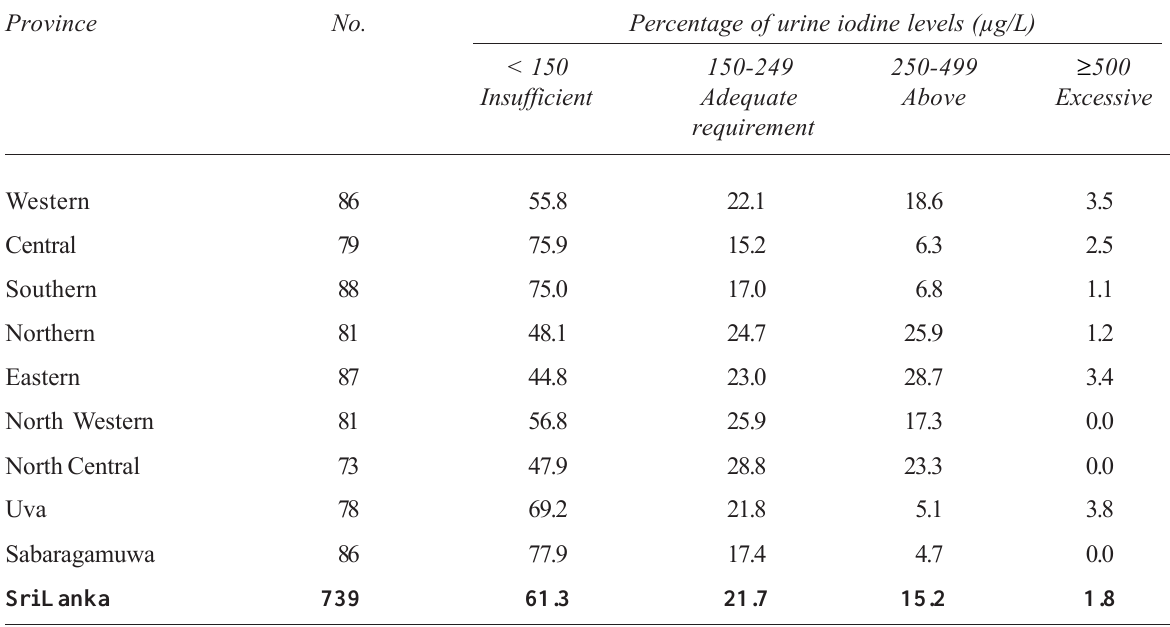
Table 2. Frequency distribution of urine iodine levels by provinces